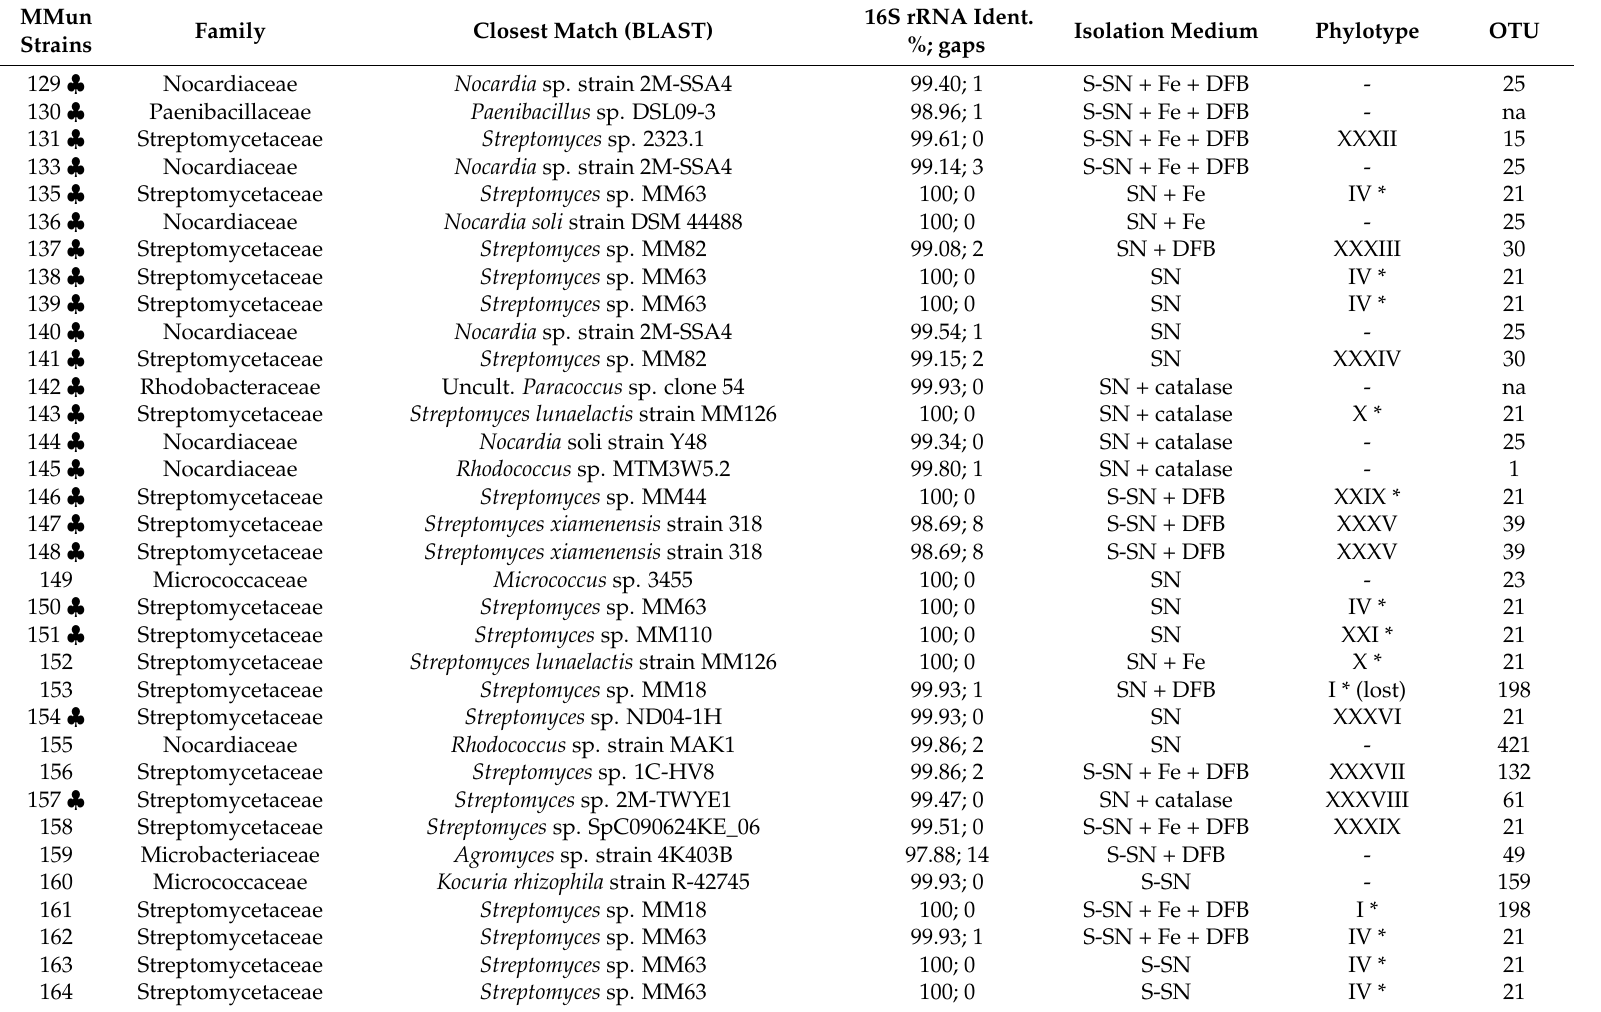
Table 1. Moonmilk strains isolated using the RC method and according to selective